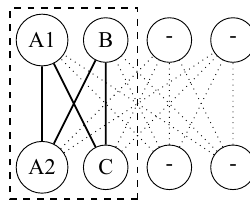
(a) An example of problem graph with a triangular structure, each variable is connected to both others. Figure 1. Example of how a problem graph, ( a ) is embedded in the Chimera annealer topology, ( b ) an earlier version of Pegasus. Each node represents a qubit and each edge a connection. Each qubit is connected to 4 others of the same cell and to others in different cells. The triangular problem graph cannot fit directly into the Chimera cell topology therefore the problem variable A becomes a logical variable represented by two different qubits A1 and A2 that will belong to a